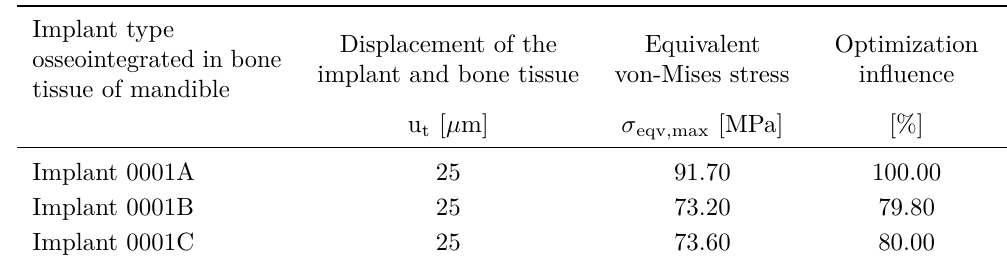
Table 1. Overview of the results provided by geometrical modification. Reference implant 0001A and modified implants 0001B and 0001C.